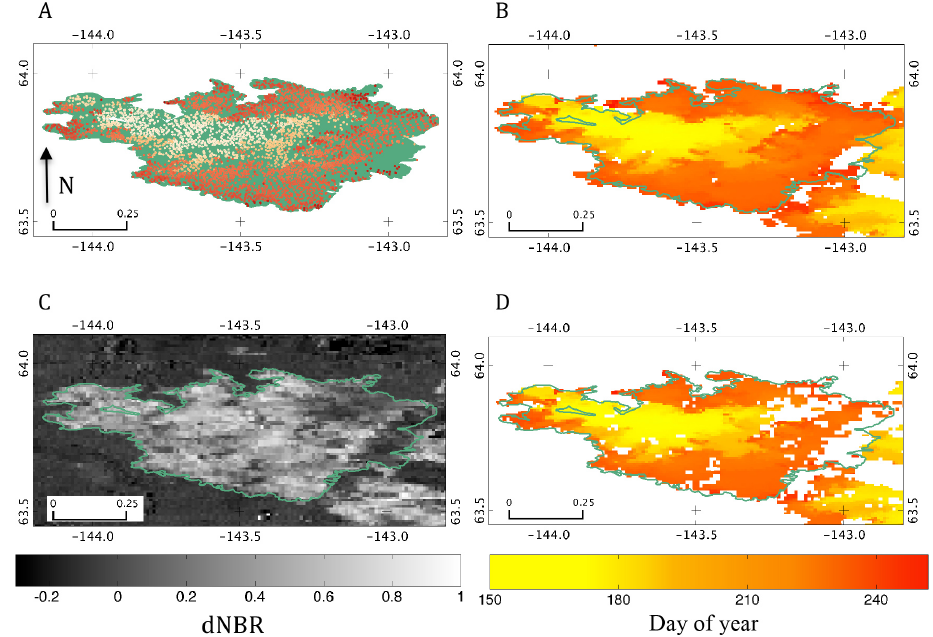
Figure 2. Active fires and daily fire spread for the Billy Creek fire that burned during the summer of 2004. (A) Active fires within the LFDB perimeter; (B) the fire spread map after spatial interpolation; (C) the difference-normalized burn ratio index (dNBR) estimated from 500m MODIS data from June 2003 (pre-fire) and June 2005 (post-fire; (D) fire spread map after applying dNBR-based mask to remove unburned